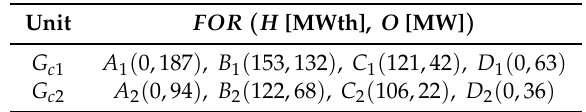
Table A4. The heat-power feasible operation region parameters of CHP units.